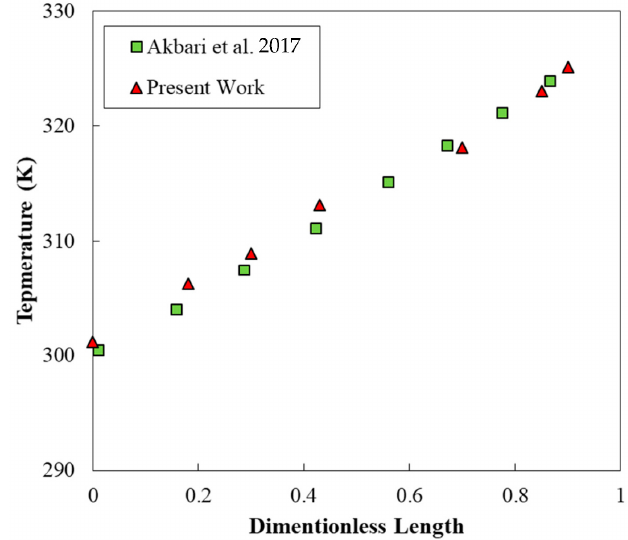
Figure 3. Validating the current solution with the data of Akbari et al. [39].